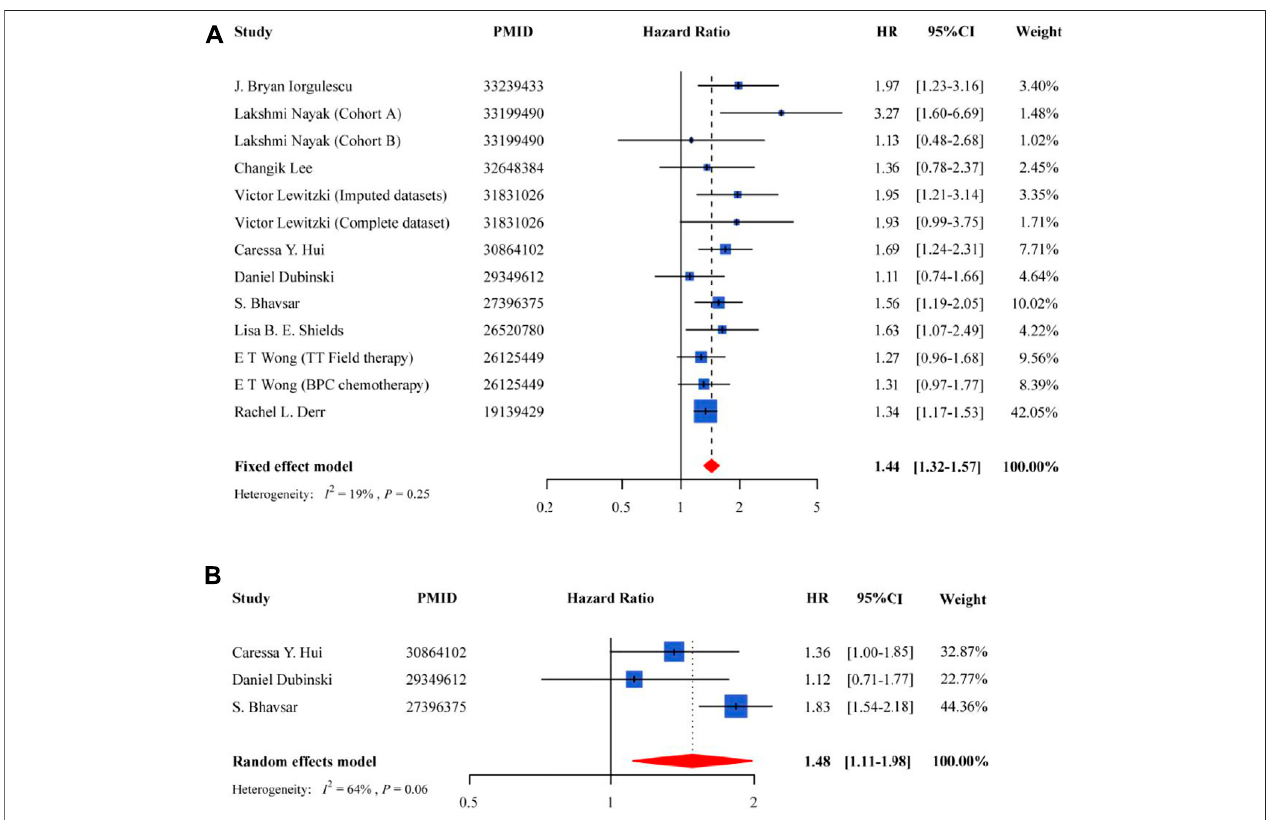
FIGURE 2 | Forest plot for the association between the use of DEX and overall survival of GBM patients (A) and progression-free survival of GBM patients (B) .